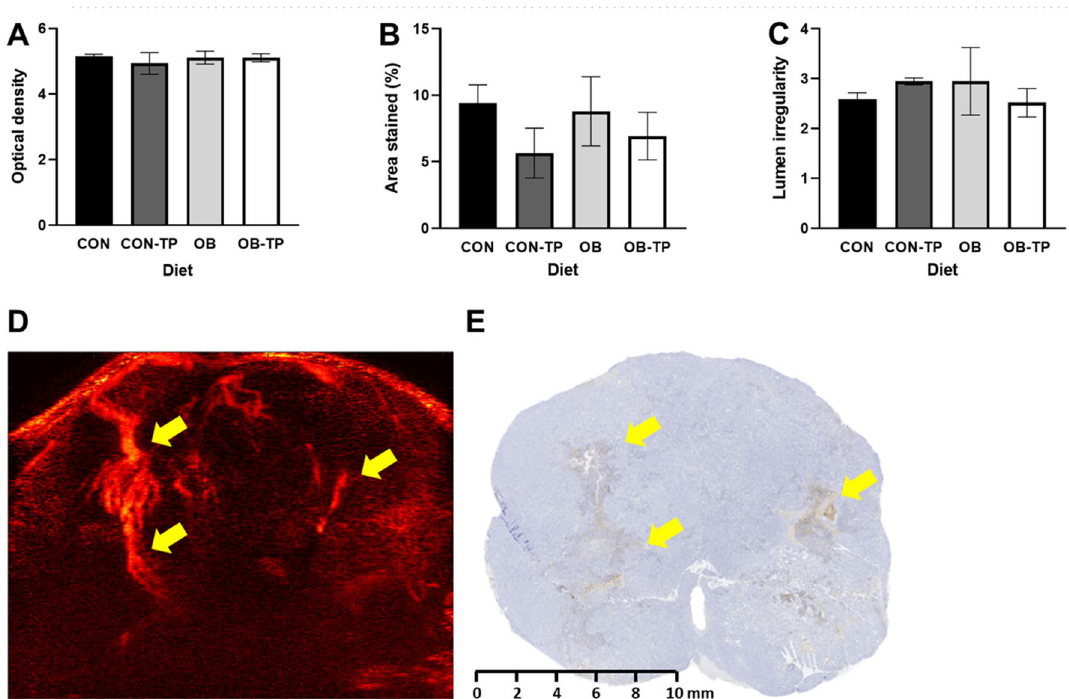
Figure 4. ( A ) Optical density and ( B ) density of intratumoral endothelial cell staining. Numeric trends indicate reduced microvessel density in TP-fed groups. ( C ) Lumen irregularity, calculated as: perimeter2/(4 × π × area), with a value of 1.0 indicating a perfect circle and values > 1.0 indicating increasing irregularity. ( D ) Ultrasound microvessel image showing blood flow through microvasculature. Yellow arrows indicate regional similarities observed by ( E ) immunohistochemistry staining against endothelial cells. *Indicates statistical significance ( p < 0.05 by mixed-model ANCOVA with body weight at tumor detection as a covariate, n = 5/dietary